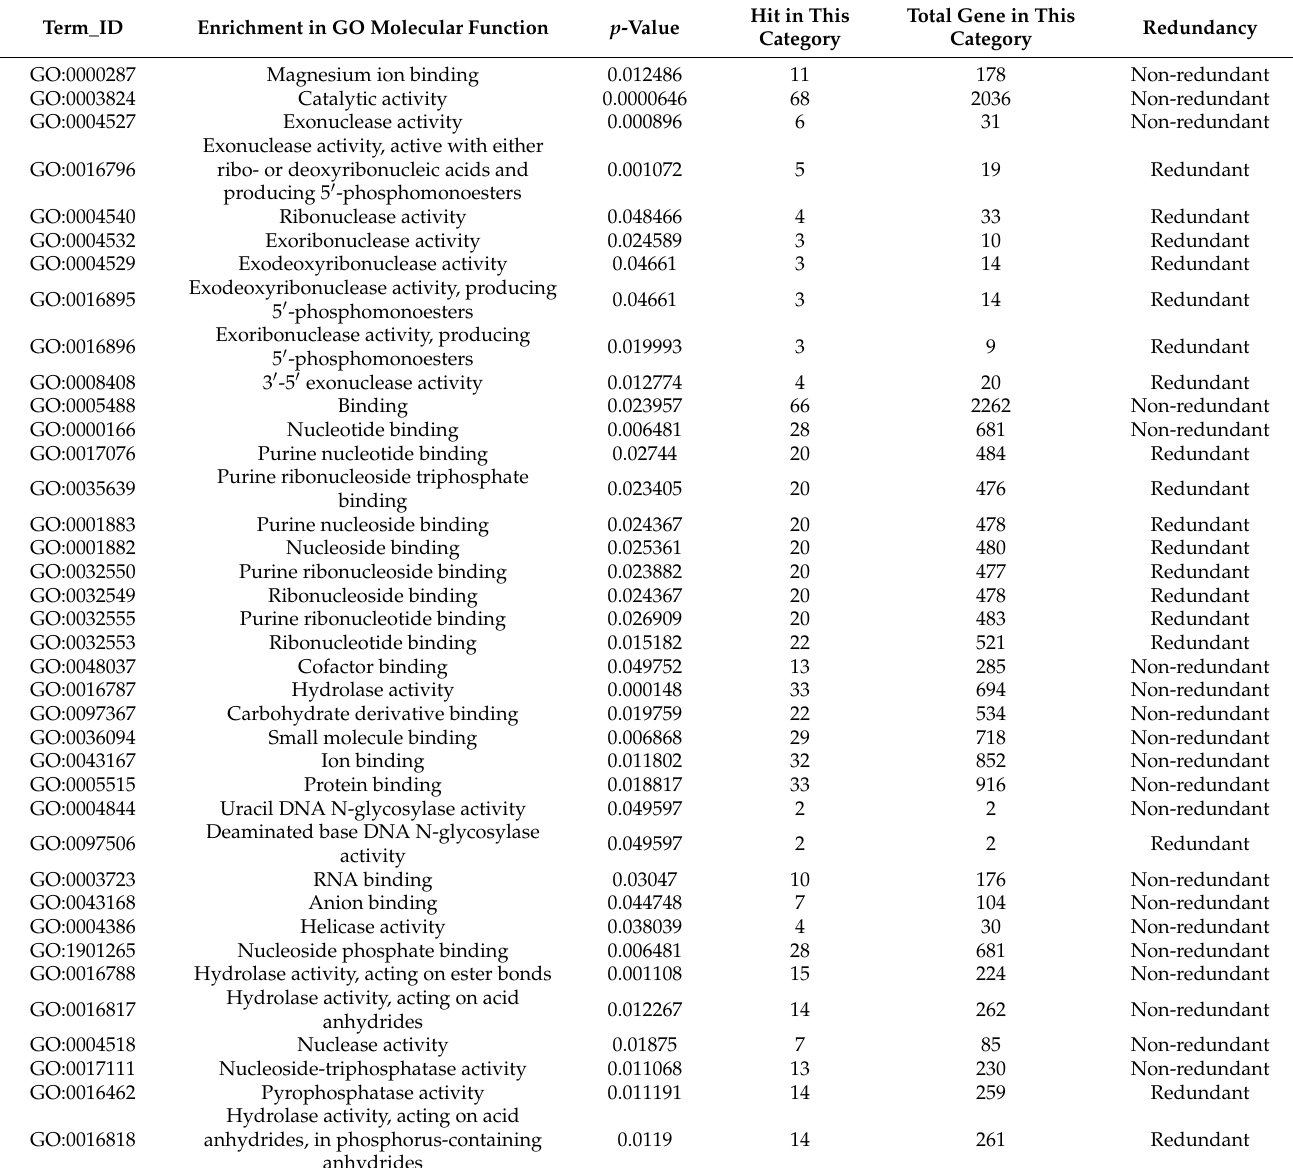
Table 1. Enrichment analysis of protein targets of polyphemusin-I in molecular function category of Gene Ontology